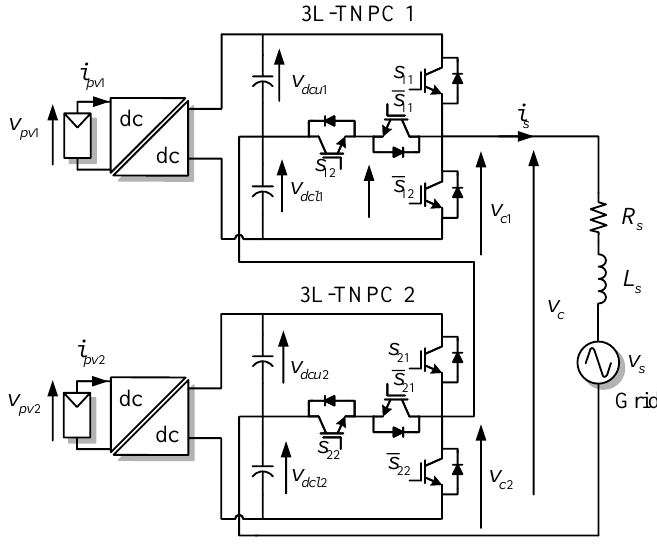
Figure 1. Proposed 5L-CTNPC power